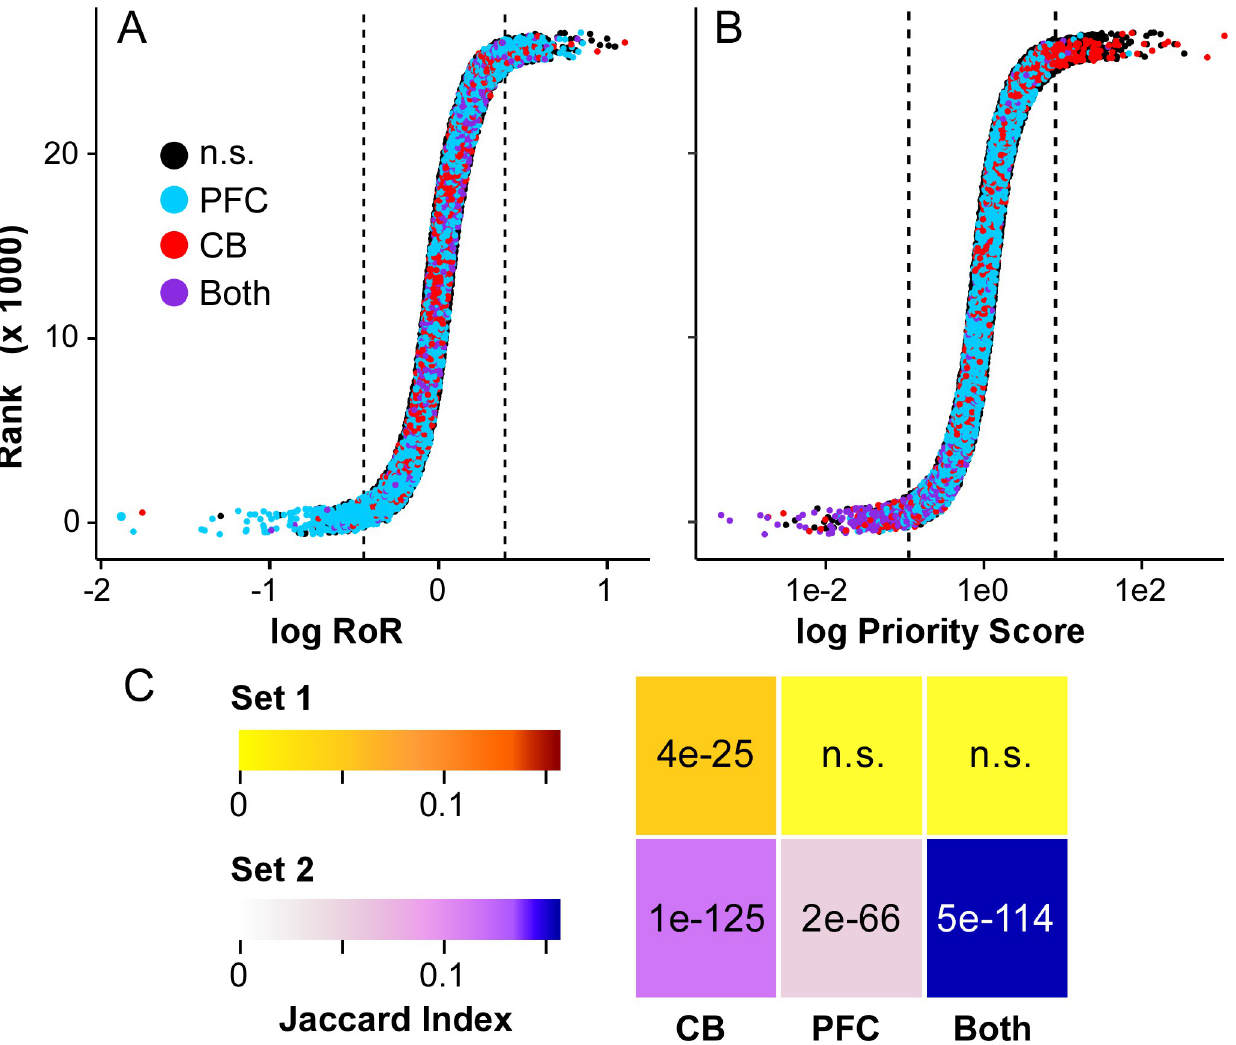
Fig 3. Rank distribution of named transcripts after RoR analysis. Jitter plots, where data points represent 25,852 named genes. Those corresponding to previously identified Braak correlated genes in PFC only (blue), CB only (red) or both PFC and CB (purple) are highlighted. All other genes are colored black. Dashed lines correspond to top and bottom 500 transcripts in each distribution. ( A ) Distribution of log RoR values, where Braak correlated genes show an even distribution across the sigmoid curve. ( B ) Distribution of log Priority Scores after subjecting RoR data to DFA. See text for details. ( C ) Enrichment analysis of Gene Sets 1 and 2 with Braak correlated transcripts, where color gradients indicate overlap by Jaccard index and numerals indicate Benjamini-Hochberg corrected p -values calculated by Fisher’s Exact Test. See text for details.